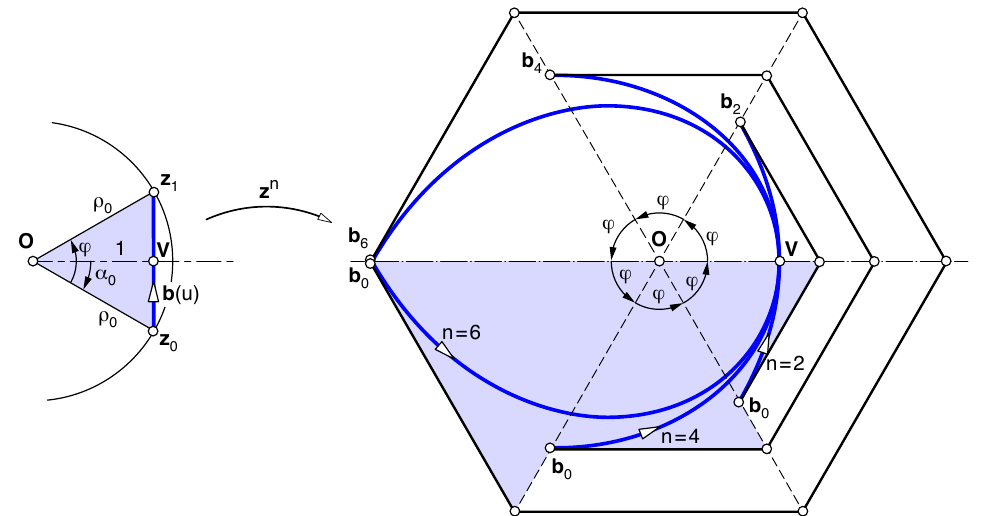
Figure 5. Degree- n symmetric curves ( n = 2,4,6 ) . The Bézier points lie on a circle C n centred at O